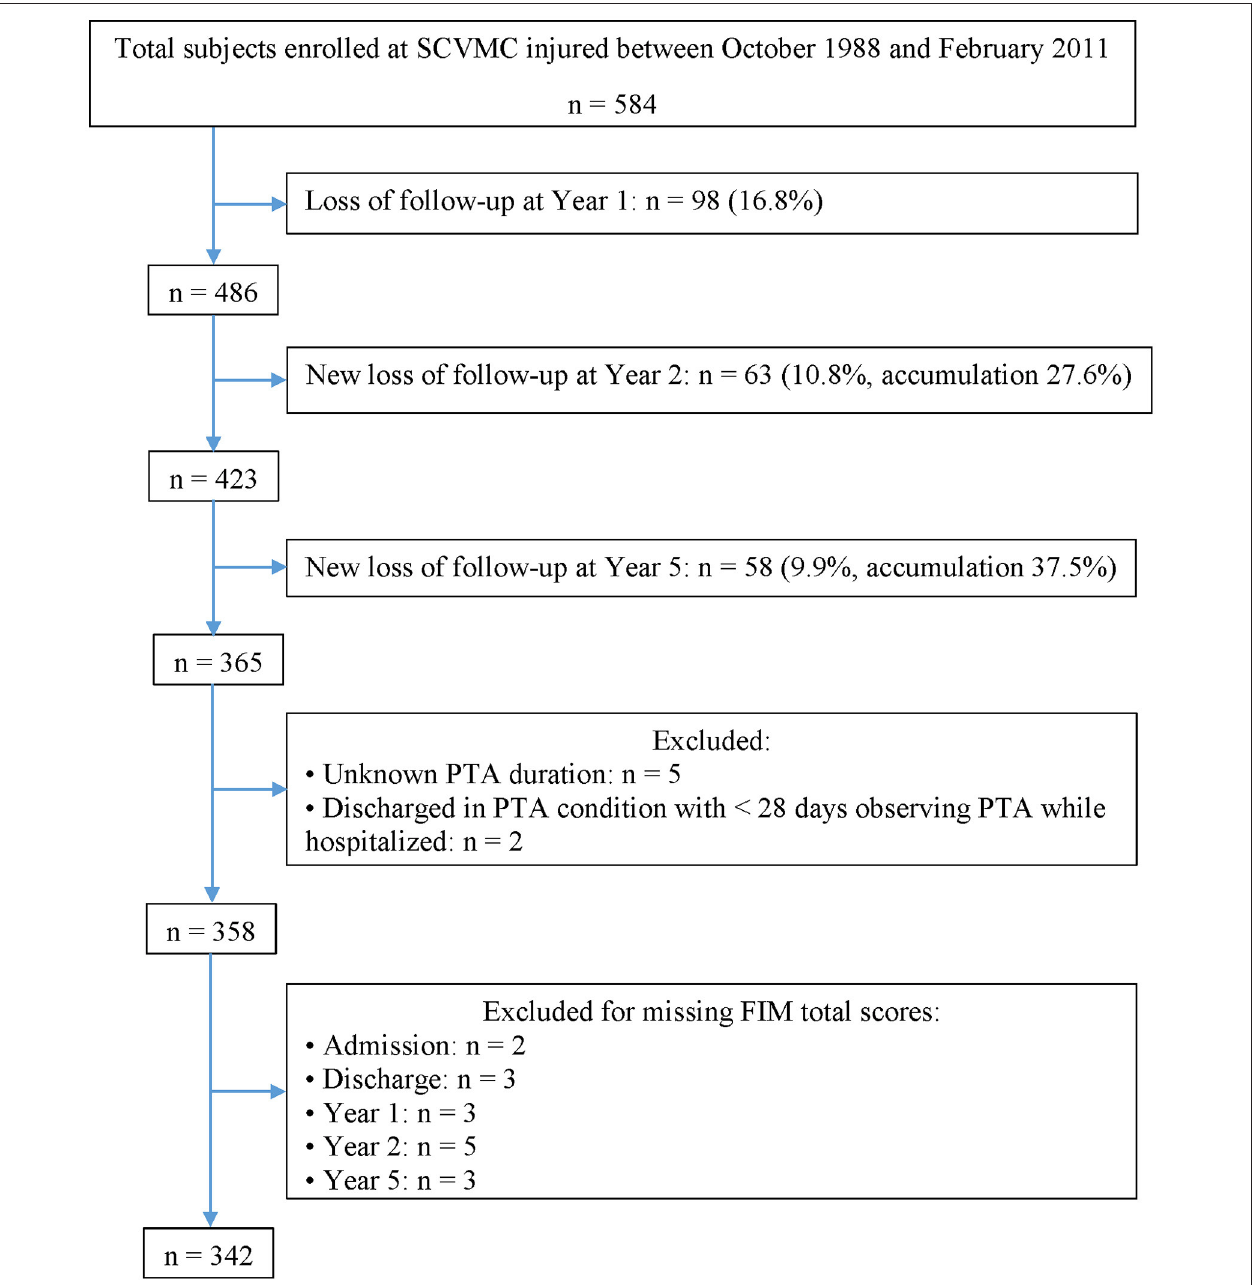
FIGURE 1 | Flowchart of the study